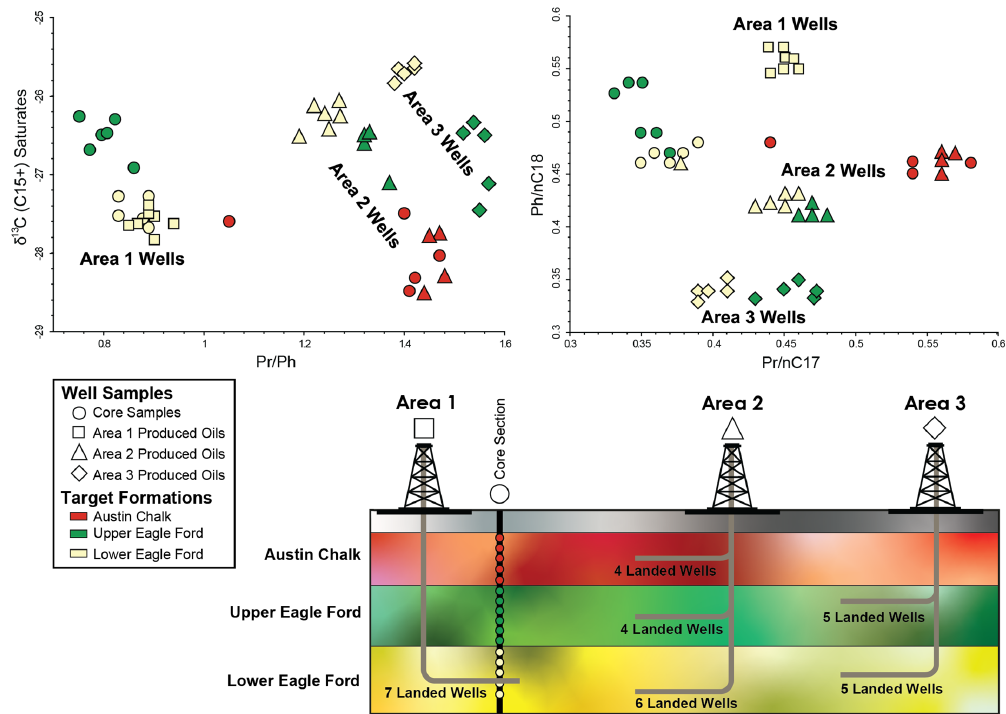
Figure 11. Geochemical comparison of unconventional wells analyzed from three sets/areas of wells targeting production from the Austin Chalk, Upper Eagle Ford and Lower Eagle Ford Formations. Each area includes a range of wells across the three formations while additional core material covering all three formations, in close proximity to area 1 is also compared. The core samples and producing areas are highlighted by the symbol type, while the landing formation is color coded, in the bivariate cross-plots and the schematic diagram. Bivariate cross-plots are shown for Carbon isotope signatures ( δ 13 C VPDB ) of the C15+ saturate relative to Pristane/Phytane (Pr/Ph) ratio and Pristane/nC 17 relative to Phytane/nC 18 .